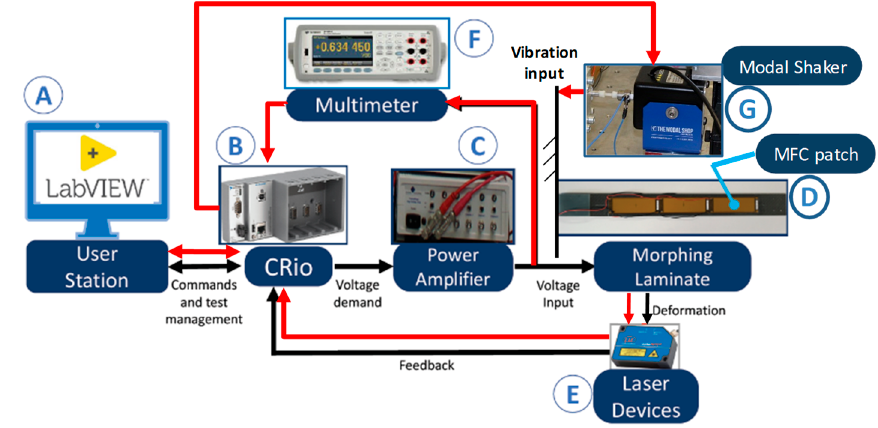
Figure 4. Experimental test system architecture.